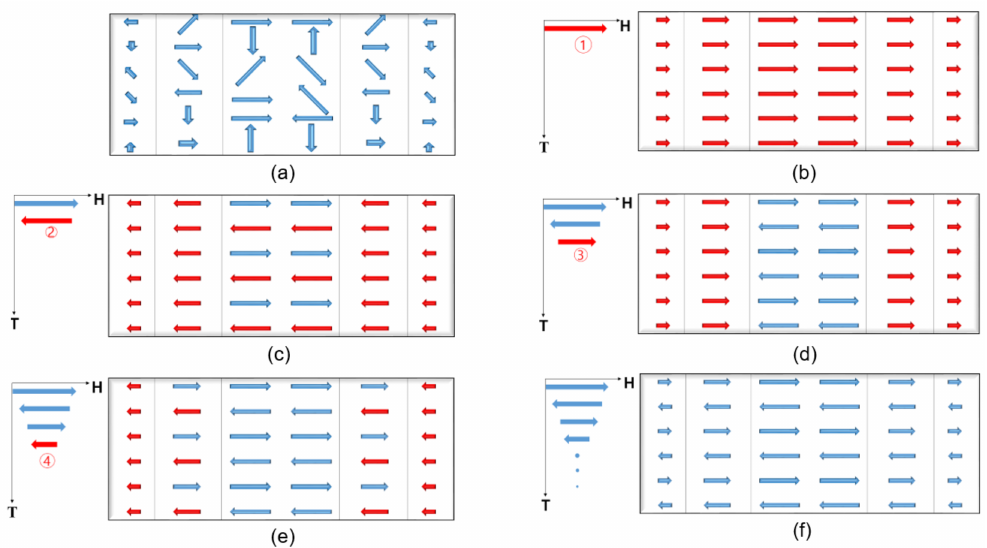
Figure 3. Magnetic domain arrangement after magnetization and demagnetization: ( a ) initial state; ( b ) magnetized state; ( c ) M2 state; ( d ) M3 state; ( e ) M4 state; ( f ) demagnetized